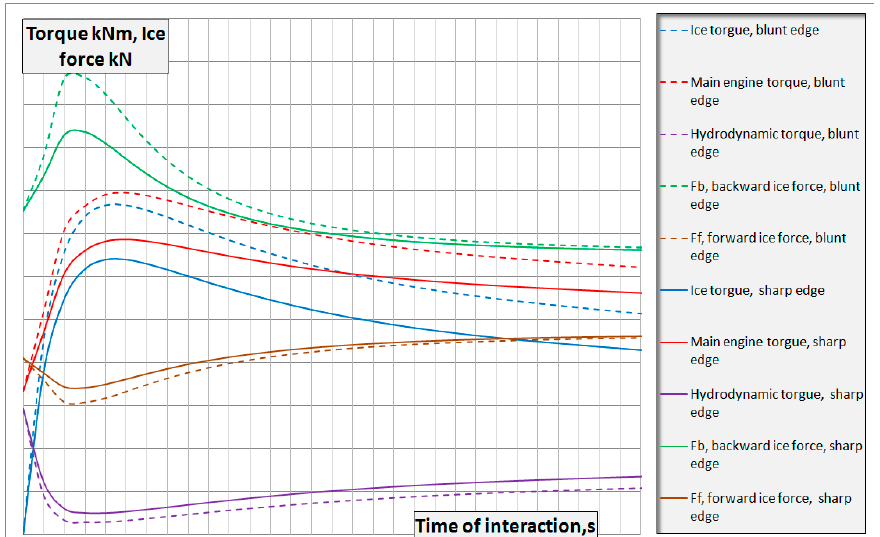
Figure 12. Ice loads and hydrodynamic torques on the propeller and MEE of azimuth unit during astern movement in ridges.